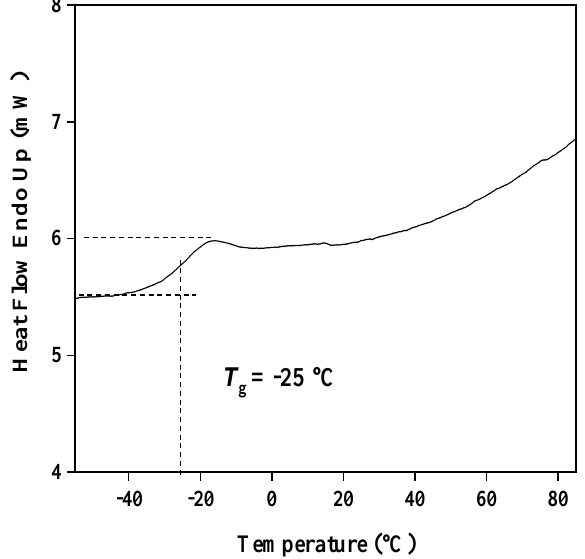
Figure 2. The glass-transition temperature ( T g ) of the copolymer MMA-BA. Table 1. The physical properties of the copolymer